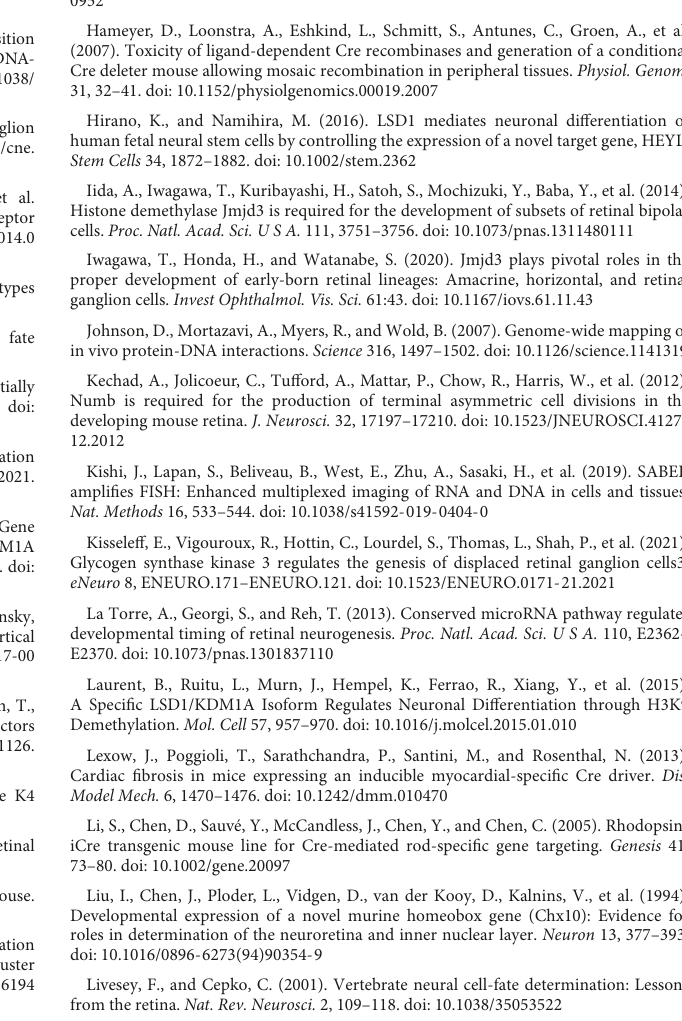
SUPPLEMENTARYFIGURE5 Rho-iCre75 Lsd1 fl / fl animals show no post-mortem obvious morphological differences compared to controls. In both whole eye (A,B) and magnified retina images (C,D) , there are no signs of obvious differences between the Rho-iCre75 Lsd1 fl / fl and the Lsd1 fl / fl control group. Additionally, there is no statistical difference in the ONL cell nuclei counts between the two groups. Two–Way ANOVA with Tukey’s multiple comparisons test. Samples